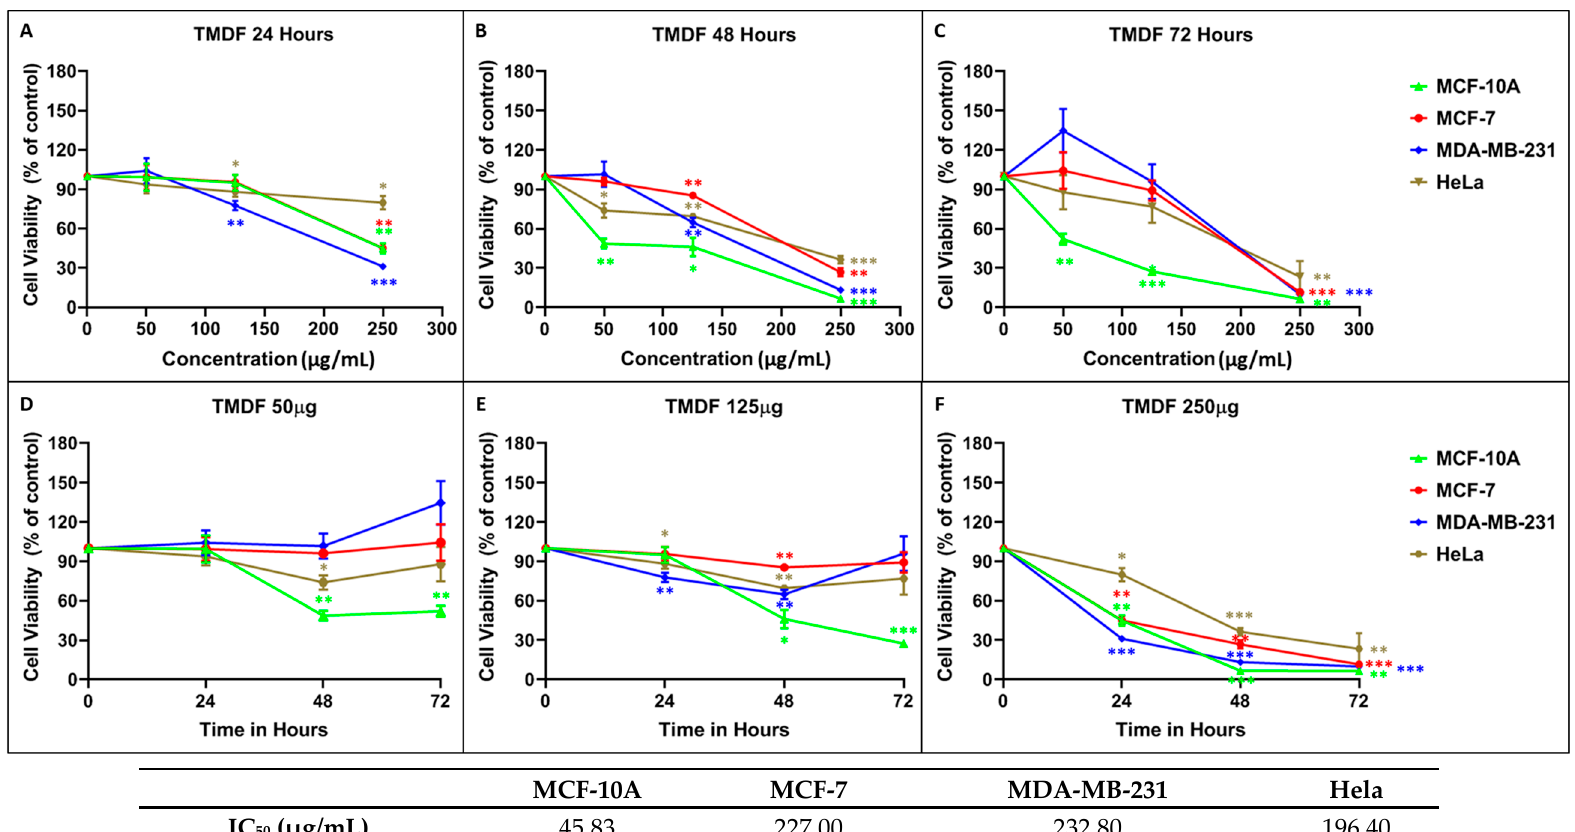
Figure 1. Cytotoxic effects of different concentration of T. mascatense dichloromethane fraction (TMDF) using MTT assay on MCF-10A, MCF-7, MDA-MB-231, and HeLa cells after ( A , D ) 24, ( B , E ) 48, and ( C , F ) 72 h post treatment. * indicates statistically significant differences between the DMSO- and TMDF-treated samples (* p < 0.05; ** p < 0.01 but > 0.001; *** p < 0.001). The IC 50 values (in µg/mL) for the 72-h time points are shown in the table below the figure .